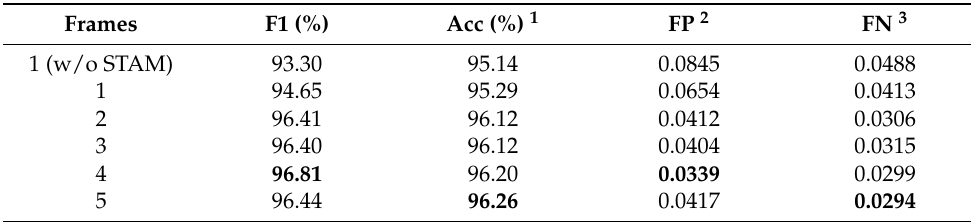
Table 1. Experimental results with the input of a different number of frames. Frames